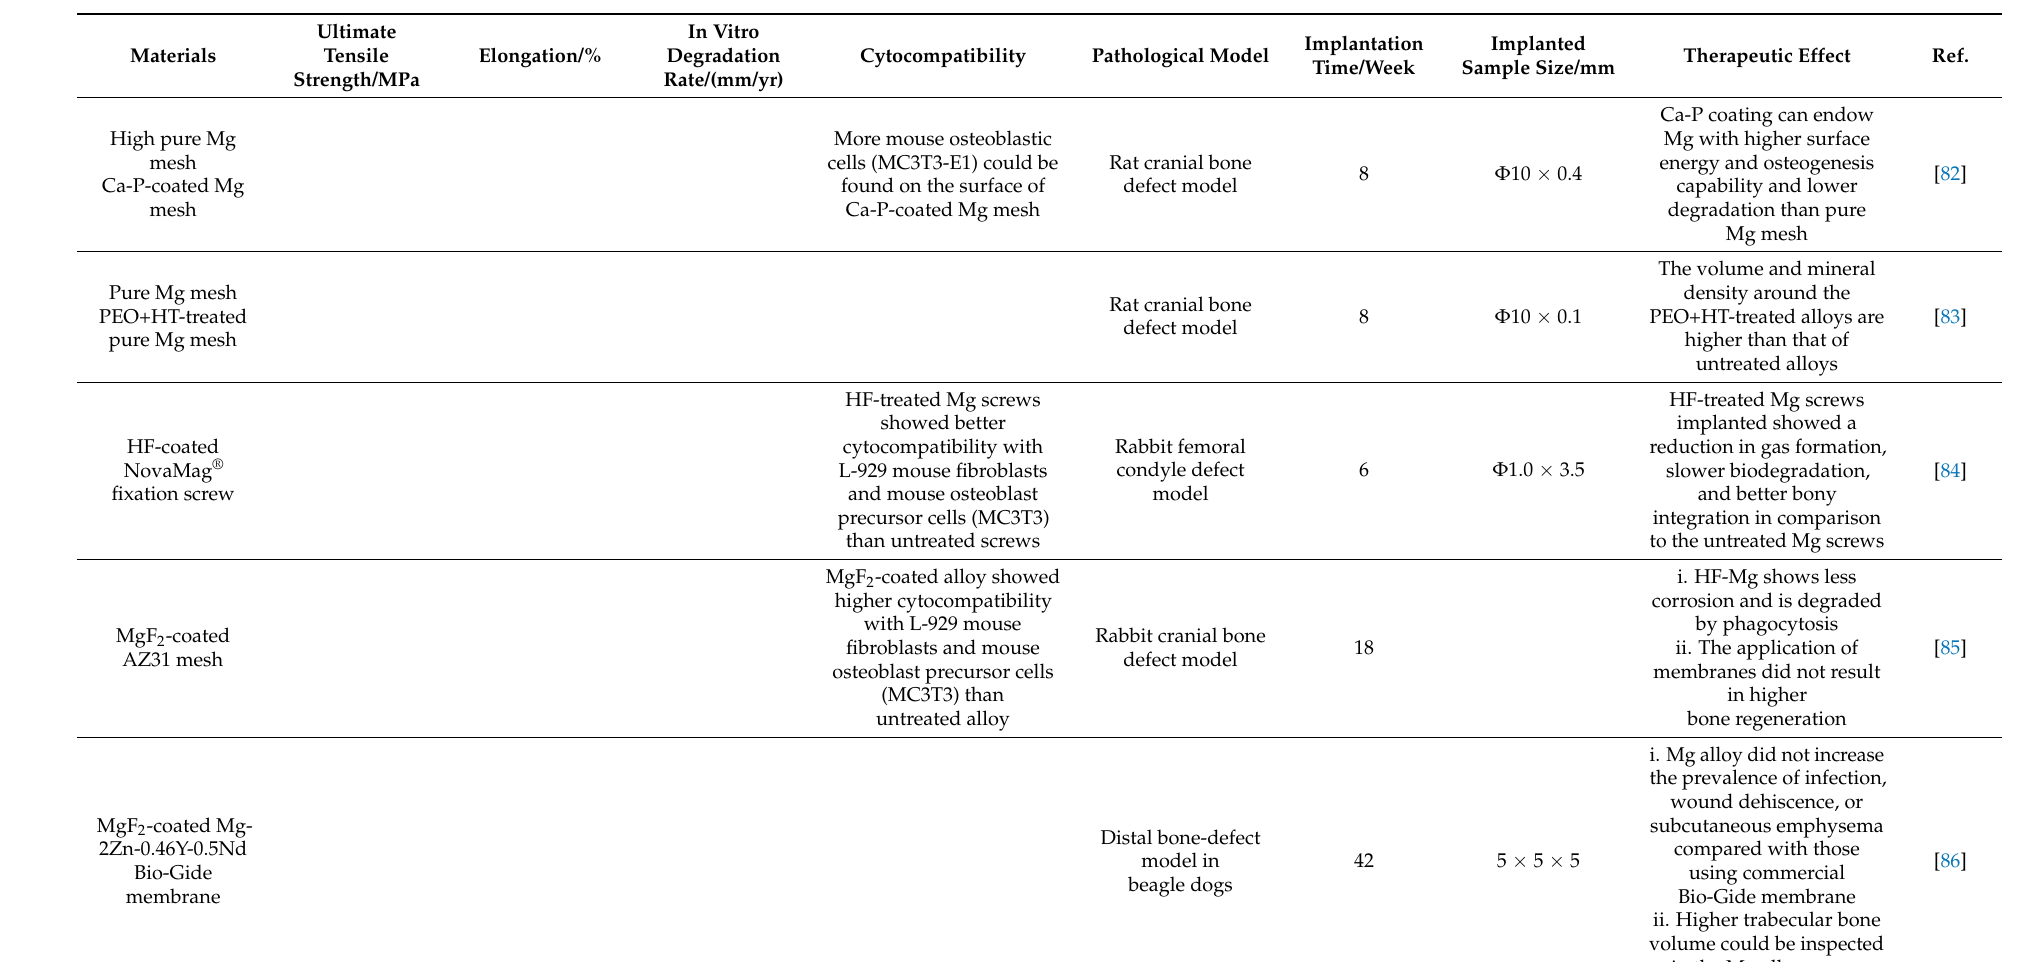
Table 2. Summary of the current research status of Mg-based GBR membranes. Data are derived from refs